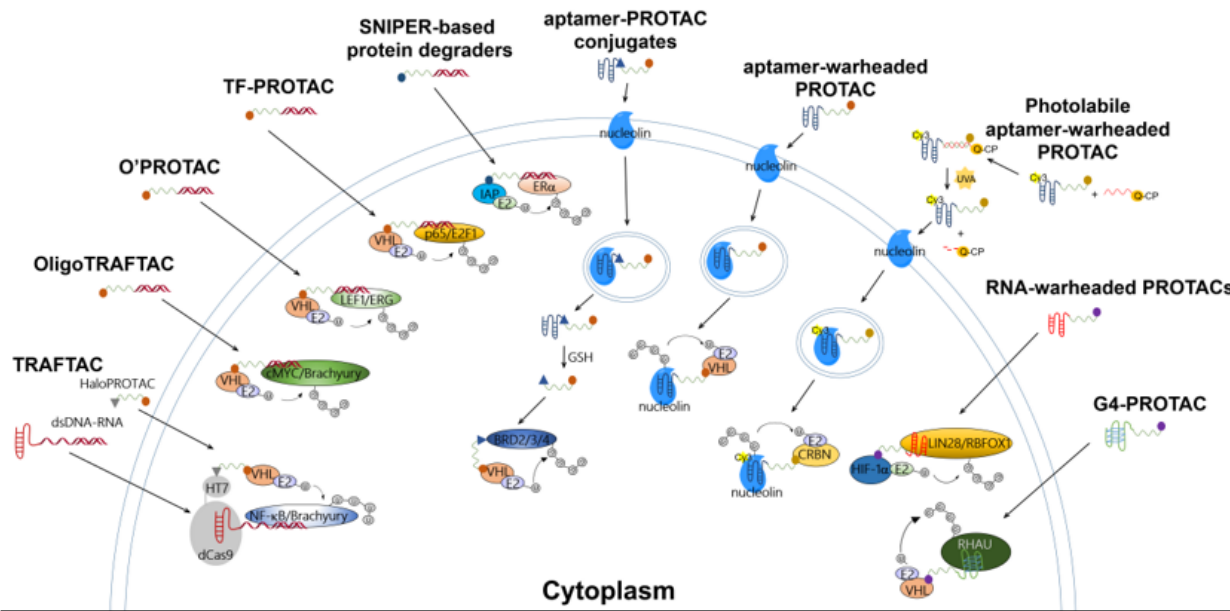
Figure 2. Ubiquitination mechanisms of reported PROTAC-based technologies for targeting TFs or RBPs. These PROTAC molecules essentially consist of an E3 binder, a linking moiety, and a POI binder. The degradation of the POI is UPS-dependent.